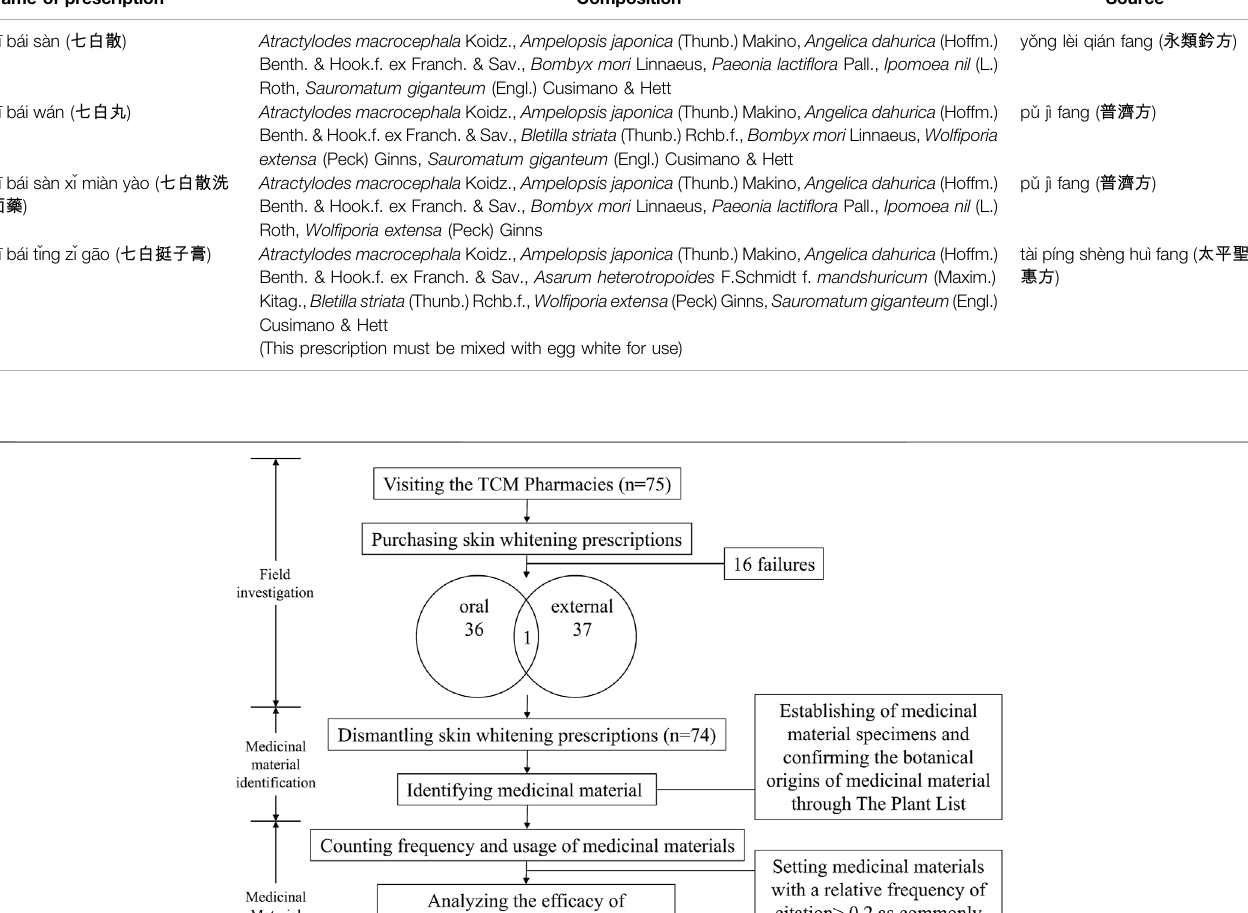
TABLE 1 | Q ī bái sàn-related prescriptions in ancient books. Name of prescription Composition Source